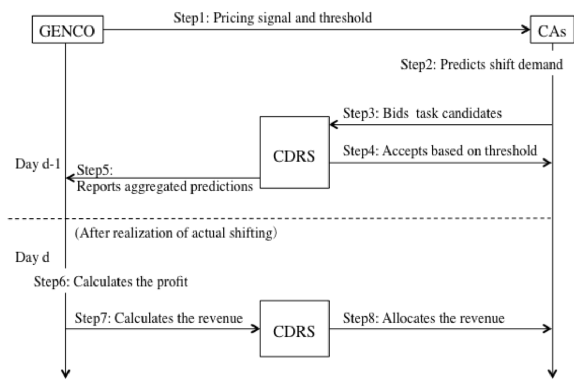
Fig. 1. CDR model